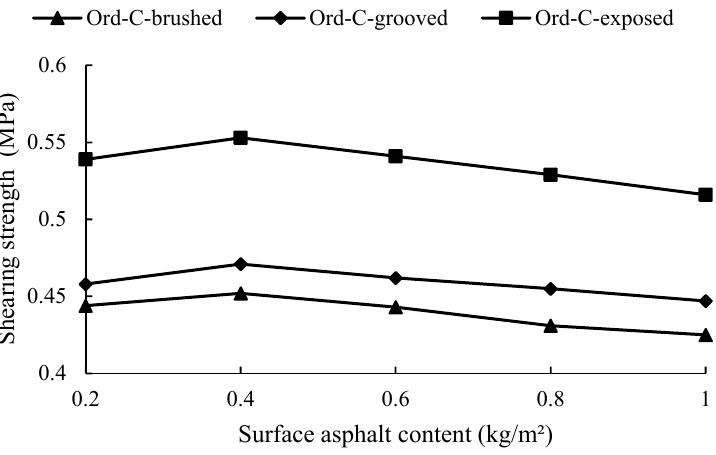
Figure 5. Shear strength of 90 ordinary hot asphalt with different asphalt content in the upper layer.